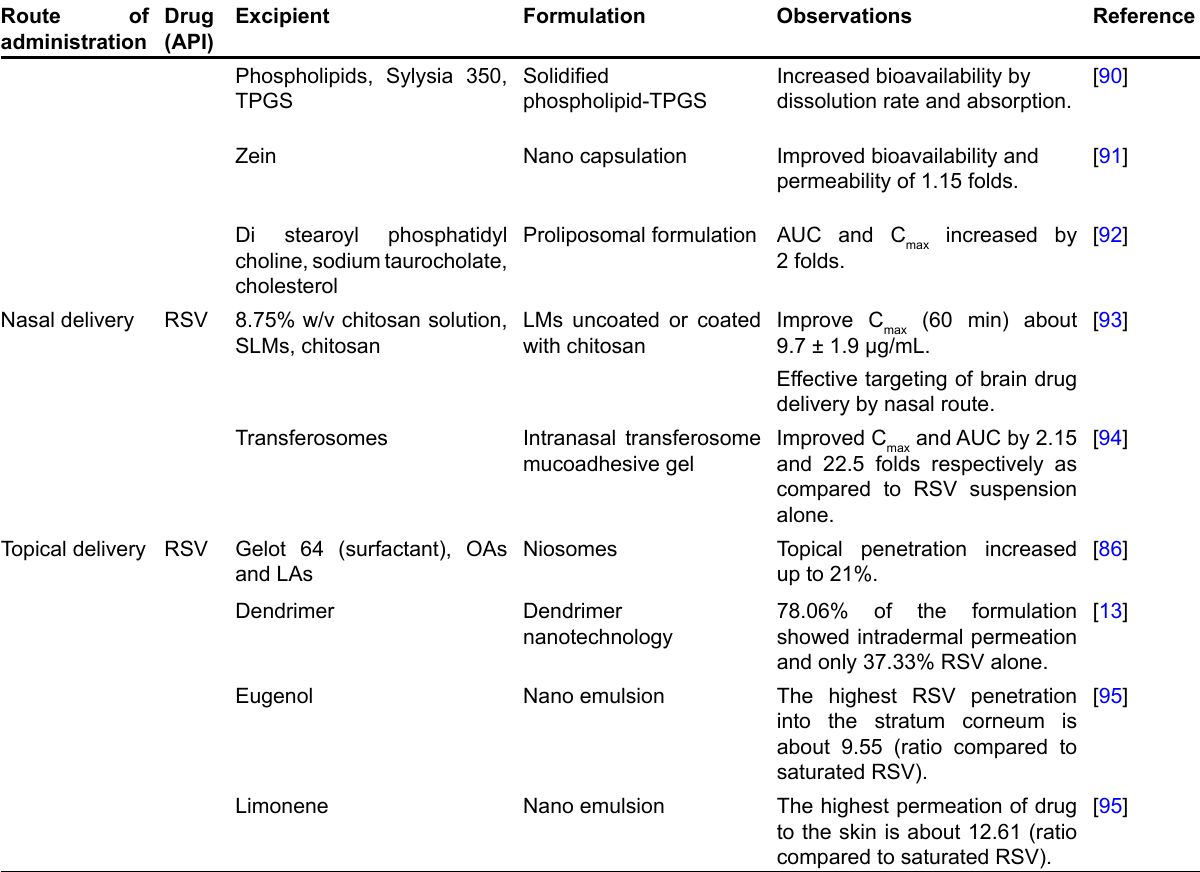
Table 1. A 10-year literature review of different nano-formulations of RSV ( continued )